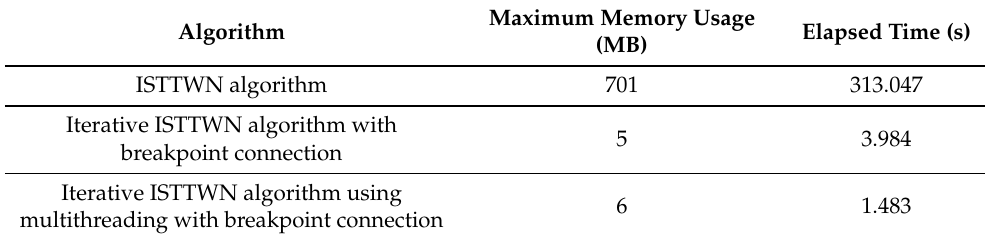
Table 3. The algorithm efficiency before and after